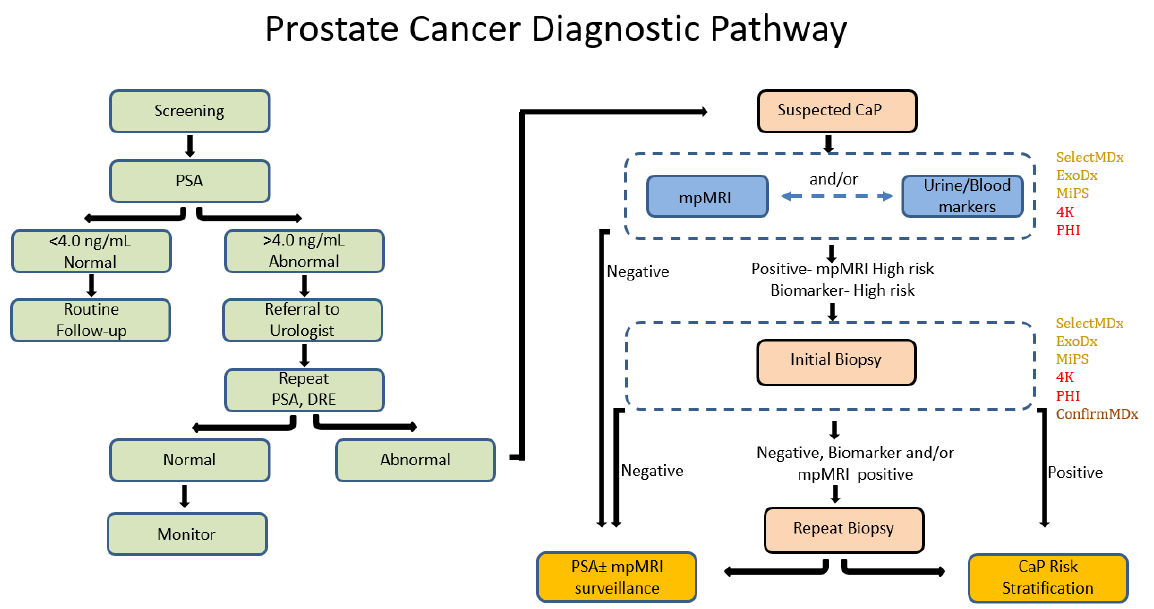
Figure 1. Schematic representation of traditional and proposed mpMRI-molecular-biomarker-directed prostate cancer diagnostic pathway. CaP, prostate cancer; PSA, prostate serum antigen; DRE, digital rectal examination; mpMRI, multiparametric magnetic resonance imaging. Text color of FDA/CLIA-approved molecular markers represents tissue of origin: yellow—urine derived; red— blood derived; brown—tissue derived.